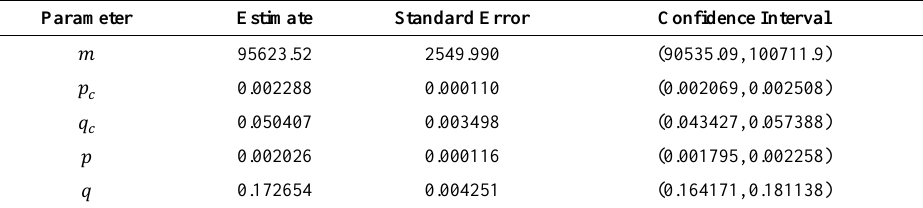
Table A10. Lombardy. Estimates, asymptotic standard errors and 95% mCIs for the parameters of the DMP (8).